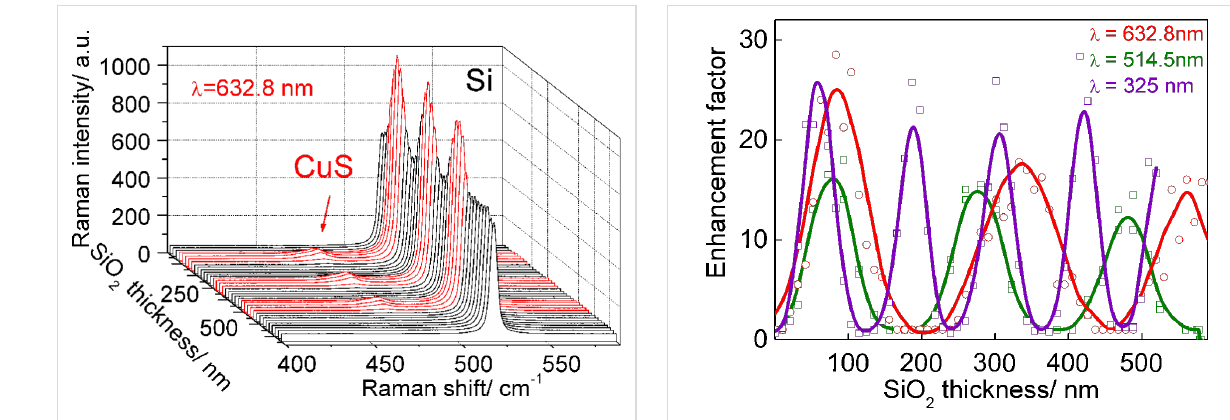
Figure 2: Raman spectra of CuS NCs (of about 1 ML coverage) fabri- cated on a Si substrate with a SiO 2 layer of variable thickness. Raman spectra were taken using 514.5 nm excitation wavelength.